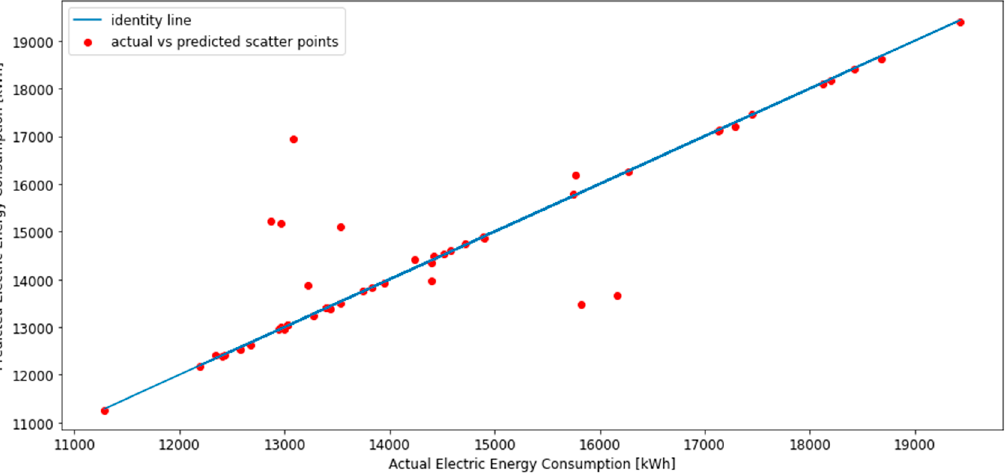
Figure 3. Correlation between EnergyPlus (true values) and surrogate model-predicted energy consumption.